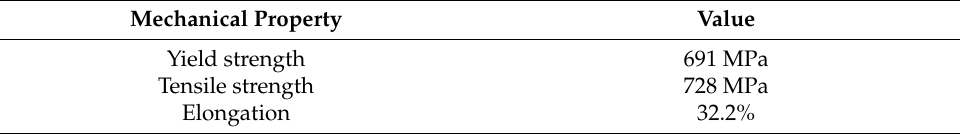
Table 2. Mechanical properties of 9% nickel steel.